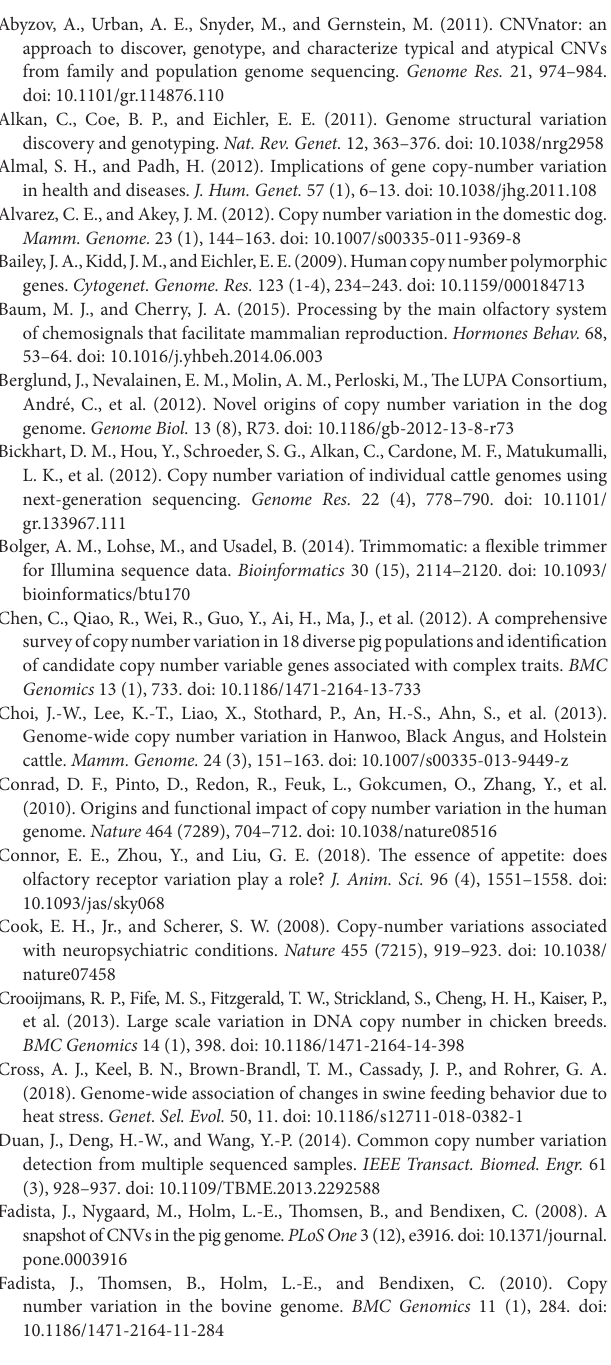
TABLE S2 | CNV overlapping between Lumpy and cn.MOPS analyses. TABLE S3 | CNVR and their overlapping genes. TABLE S4 | Distribution of CNVR in individual animals. TABLE S5 | Breed specific CNVR.